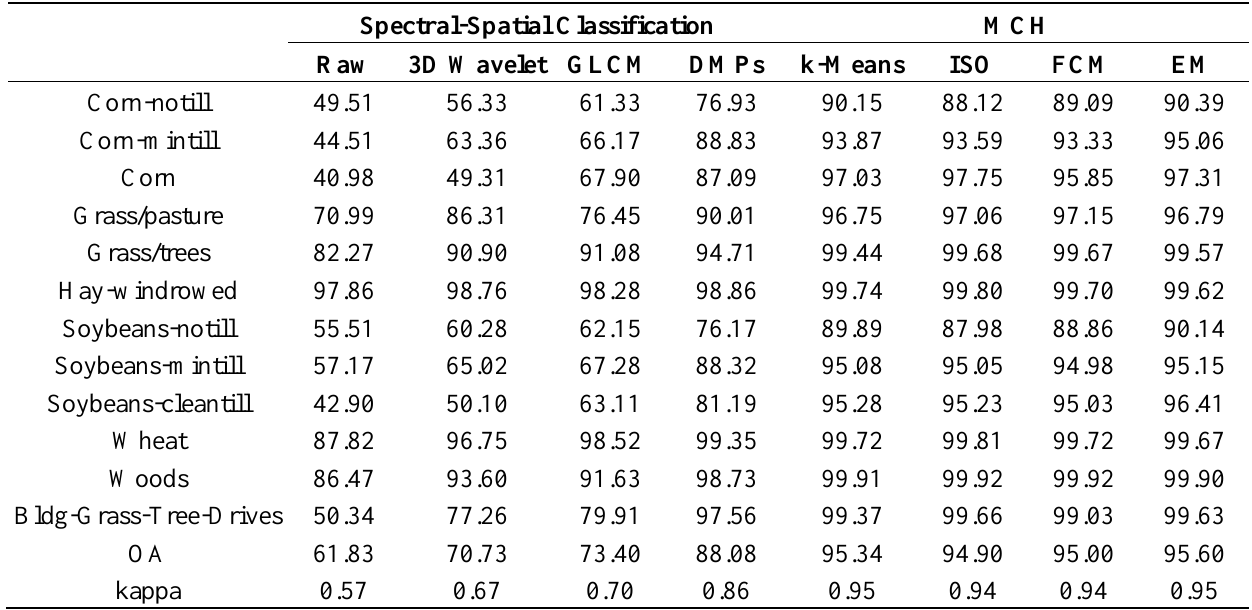
Table 5. Classification accuracies of the different features for the Indian Pines